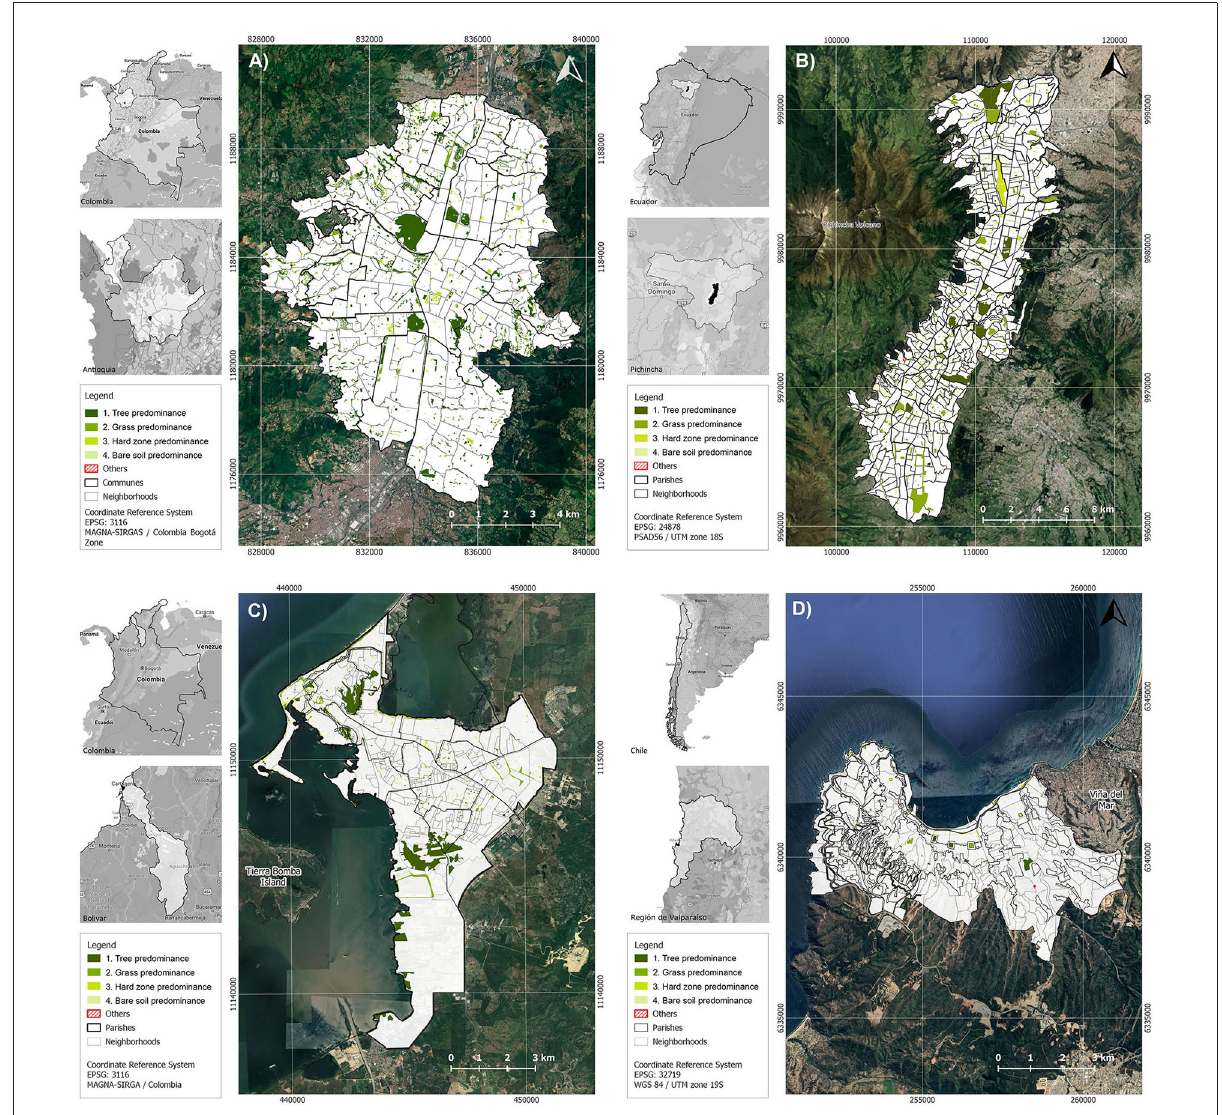
FIGURE4 Categorized public spaces: Medellín (A) , Quito (B) , Cartagena (C) , and Valparaíso (D) . Source: Prepared by the authors based on (Decreto 0977 de, 2001; Acuerdo 48 de, 2014; Cárdenas et al., 2020; Alcaldia de Medellin, 2021; Alcaldia de Quito, 2021b; Alcaldia Mayor de Cartagena de Indias, 2021; Ministerio de Vivienda y Urbanismo de Chile,